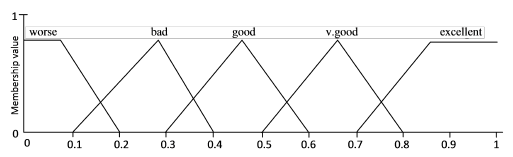
Fig. 2. Fuzzy logic framework